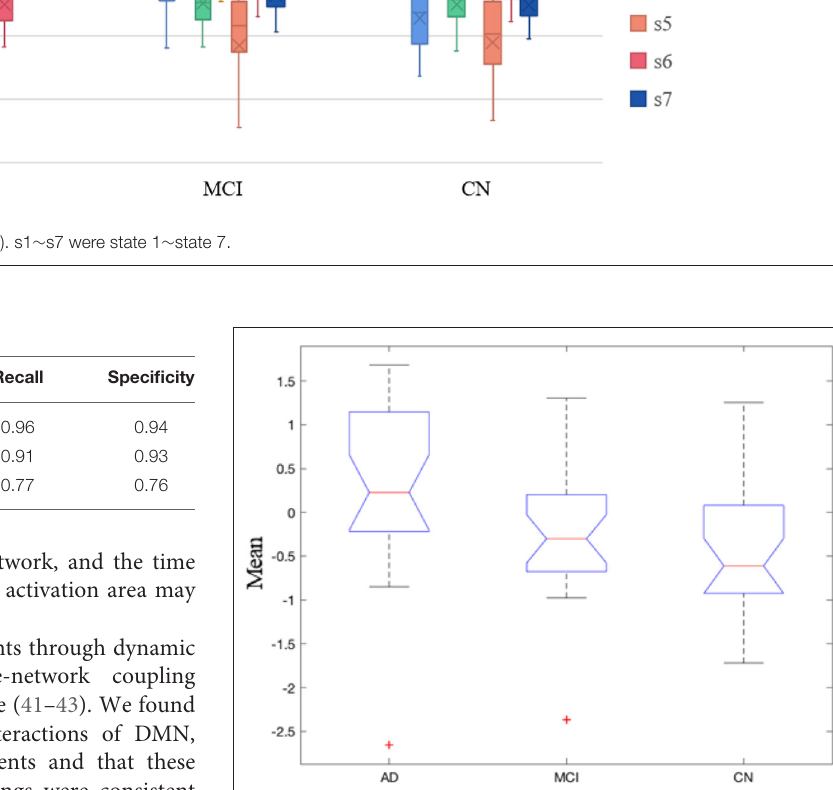
FIGURE 7 | Mean of dynamic triple-network interactions in the three